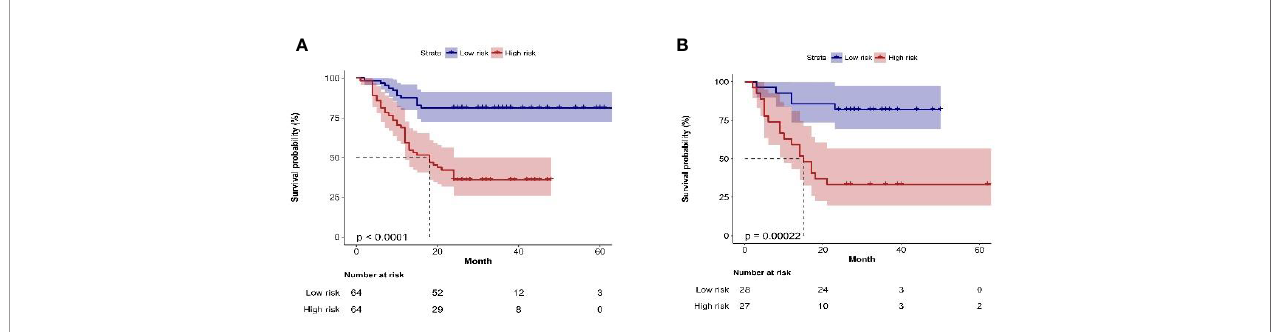
FIGURE 6 | (A, B) Kaplan – Meier plots of bladder cancer within 2 years after surgery in the training group and the validation group constructed by recurrence risk strati fi cation based on